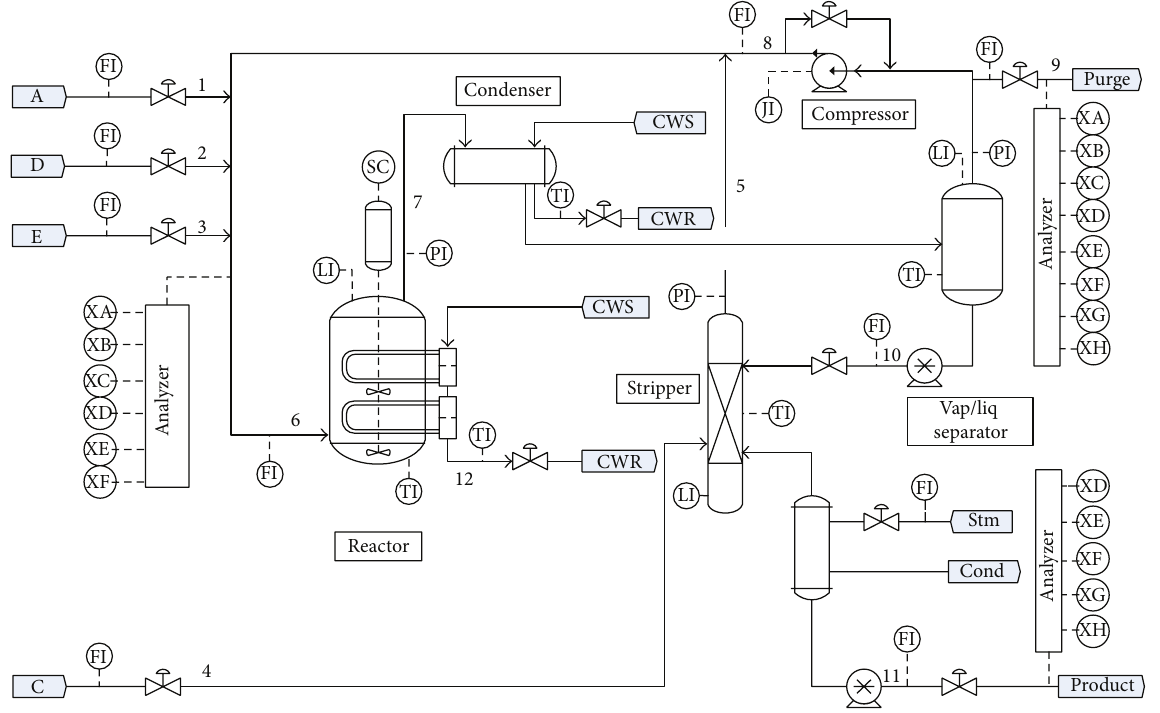
Figure 1: The flowsheet of TE